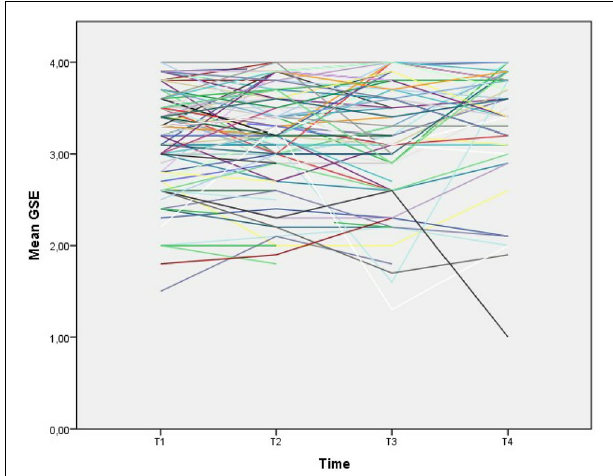
FIGURE 2 | Individual levels of self-efficacy over time. Individuals’ mean levels of self-efficacy were measured with the Generalized Self-Efficacy Scale at each assessment